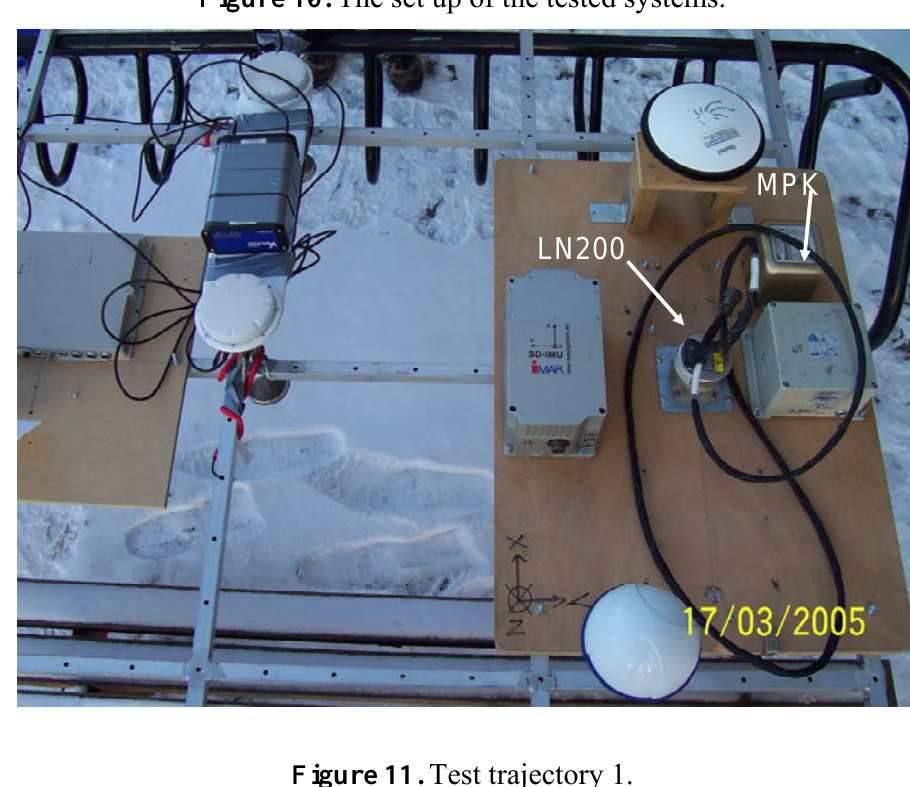
Figure 10. The set up of the tested systems.